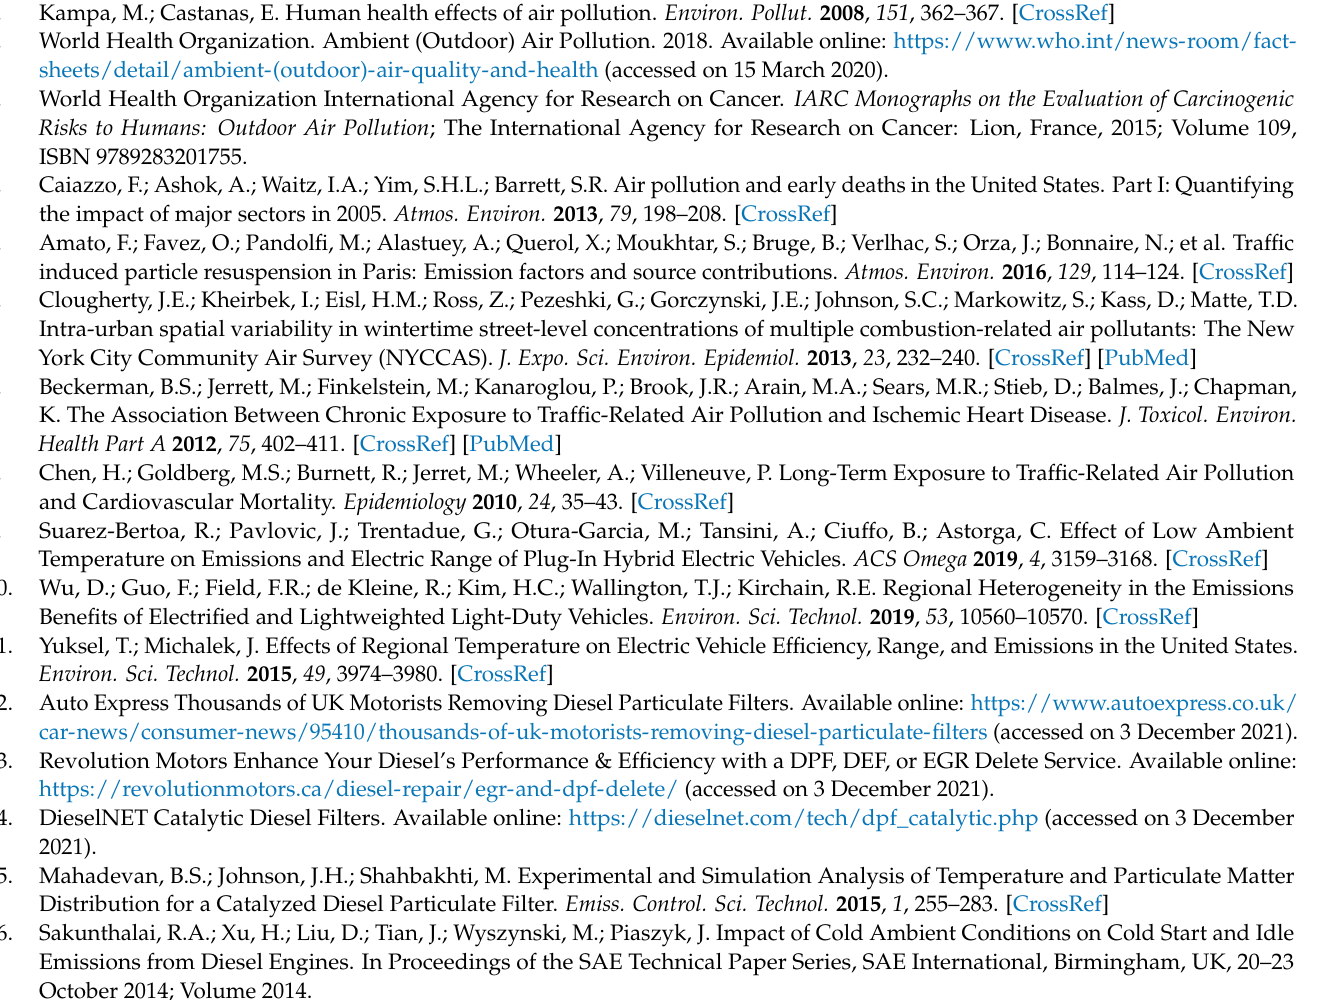
Table S2. The complete data on the pollutants tested in the papers reviewed (no pattern of specific pollutants tested at the same study was found). Table S3. The complete data on the papers which studied seasonal associations with health outcomes: types of health outcomes, pollutants associated, and temperature range indicated (no pattern